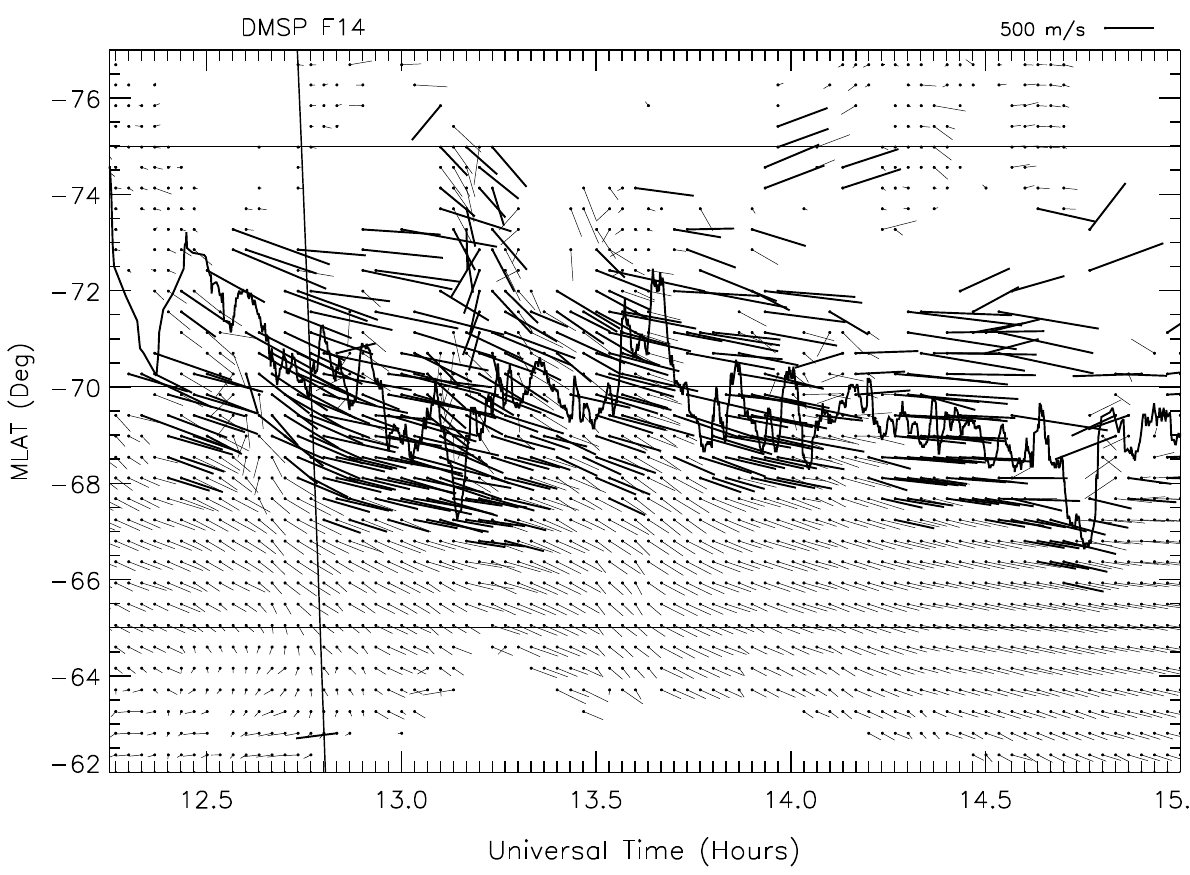
Fig. 5. Two-dimensional flow vectors estimated along TIGER beam 4 using the beam-swinging technique at 2-min time resolution during 12:15 to 15:00UT, 10 December 1999. The solid dots correspond to the time and latitude of the velocity estimate, and the flows were in the direction of the lines leaving the dots. Flows directed toward the right were eastward, and toward the bottom, equatorward. The scale for an eastward flow of 500m/s is shown at top right. Flows with magnitudes > 400m/s were drawn in bold to emphasize the flow bursts commencing on open field lines. The same SWB shown in Fig. 3 has been superimposed in bold. The diagonal line starting at 12:45UT represents the transit of the DMSP F14 satellite (c.f., Fig.